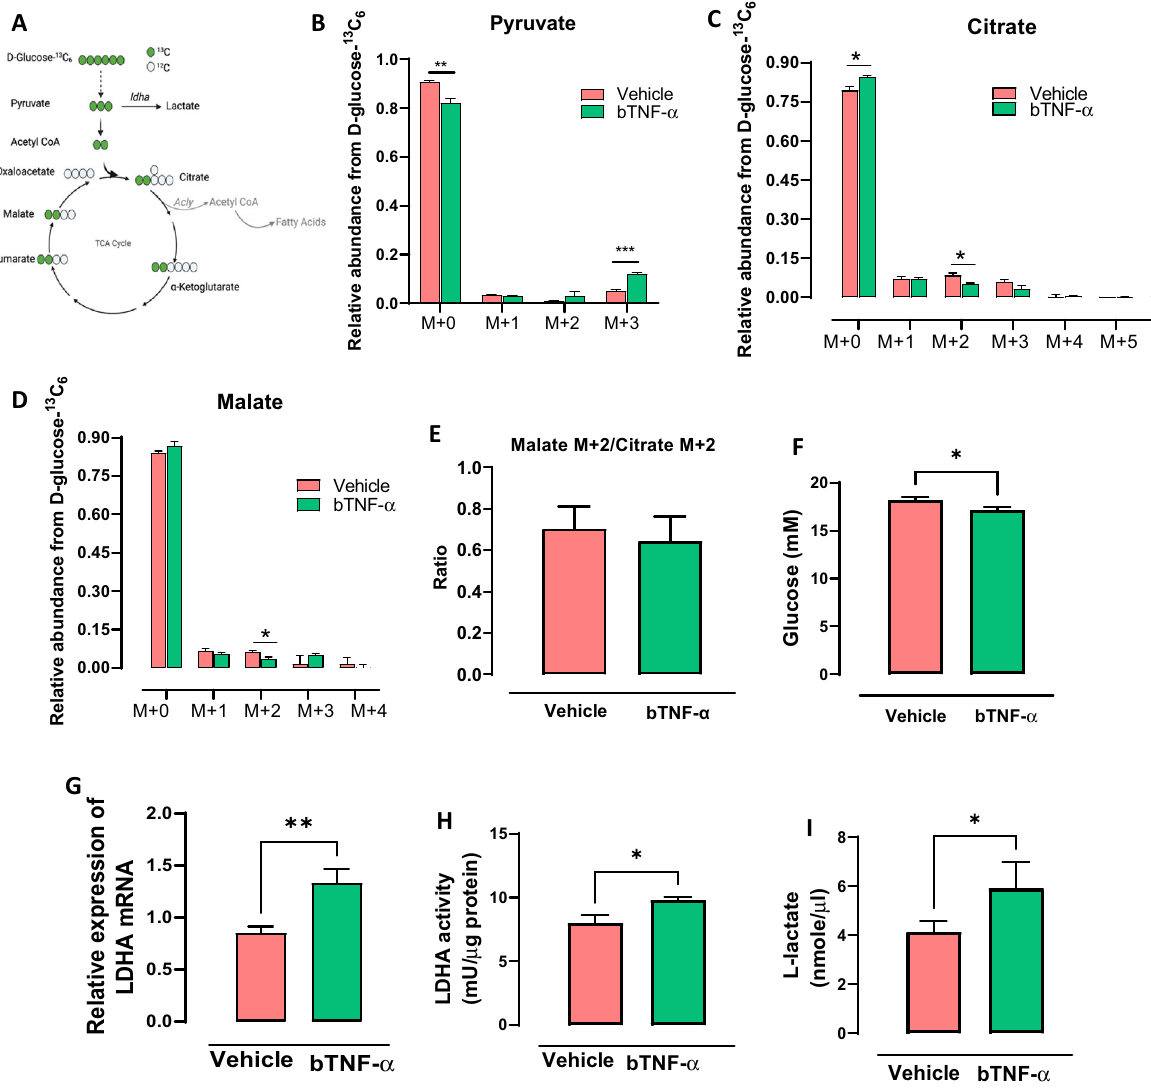
Figure 2. Metabolic shift induced by 100 ng/ml bTNF-α in bFLS. ( A ) Schematic representation of flux from D-glucose- 13 C 6 metabolism. Created with BioRender.com. MID profiles of ( B ) pyruvate, ( C ) citrate and ( D ) malate derivatives from D-glucose- 13 C 6 metabolism induced by bTNF-α. n = 3. * p < 0.05 compared with vehicle. ( E ) Ratio of malate M + 2/citrate M + 2 to infer fractional canonical TCA cycle. Levels of ( F ) Glucose ( G ) mRNA expression of LDHA, ( H ) enzymatic activity of LDHA and ( I ) extracellular concentration of L-lactate. n = 4. ** p < 0.01; * p < 0.05 compared with the control. Each bar represents the mean ± standard error of the mean (SEM), n = 4, independent